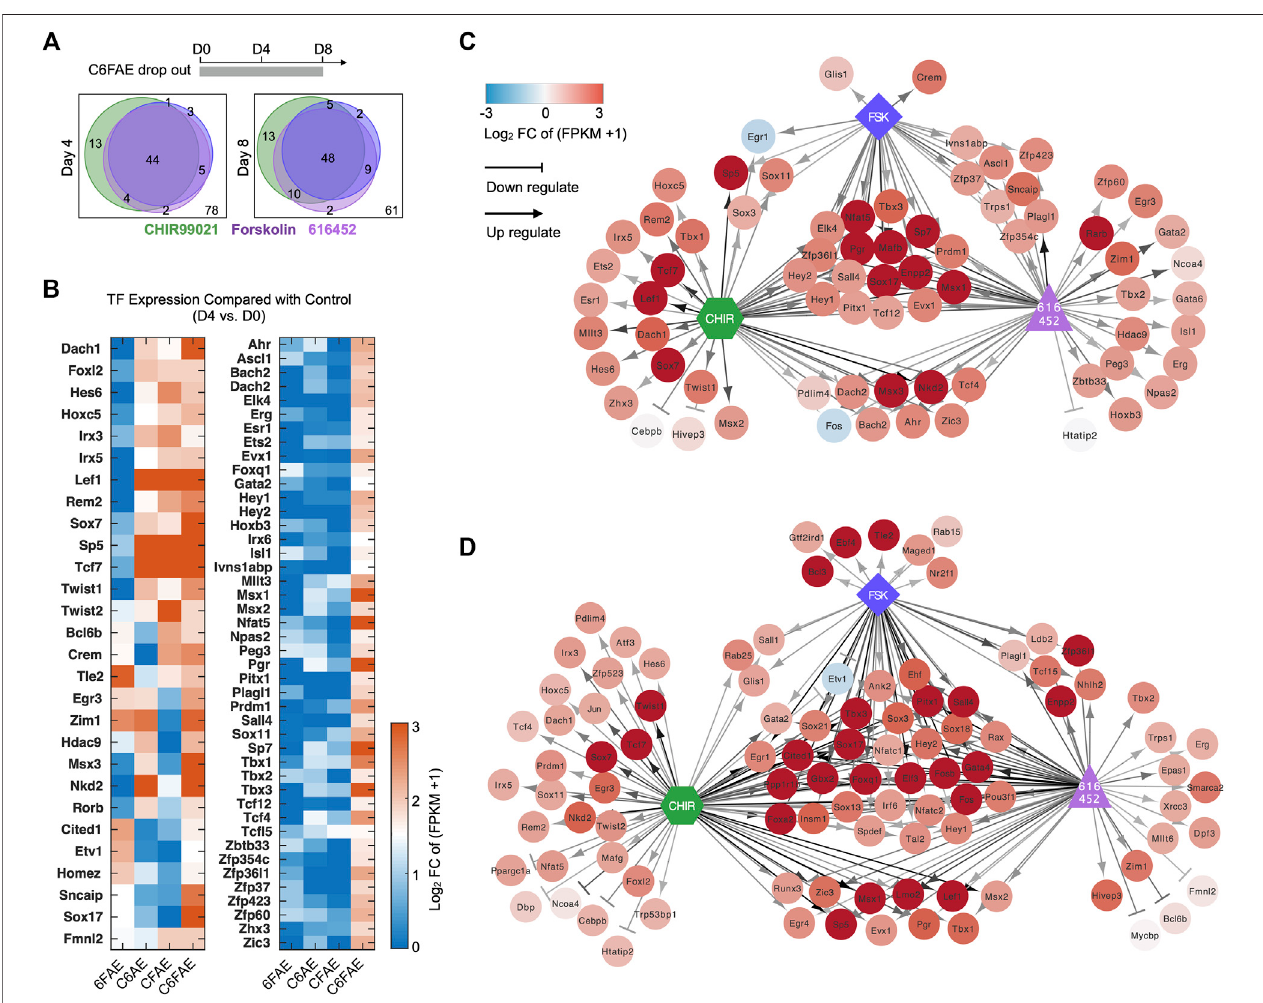
FIGURE4| Corereprogrammingchemicals(C6F)concomitantlyinducetheCaMPphase. (A) VenndiagramofTFsactivatedbyC,6,andF,respectively.Thegene list was limited to 150 TFs activated by C6FAE. Genes were assumed to be activated by C, 6, or F at day 4 (or day 8) when they were upregulated more than 1.5 in normalized FPKM with the treatment of C6FAE while not being with subtracted each chemical. (B) TFs regulated by C, 6, and F during the fi rst 4 days of XEN reprogramming.TheexpressionoftheseTFsonday4wascomparedwiththeirexpressioninMEFsinnormalizedFPKM.Thecolorkeyisproportionatetothevalue of data of day 4subtracted by data of MEFs. (C, D) TFs expressed differently when C, 6, and F were removed from the cocktail C6FAEin the fi rst 4 days (C) and 8 days (D) . Red points: upregulated genes in C6FAE treated cells; blue points: downregulated genes in C6FAE treated cells. Arrows represent promotion, and horizontal lines represent inhibition. The darker lines mean stronger